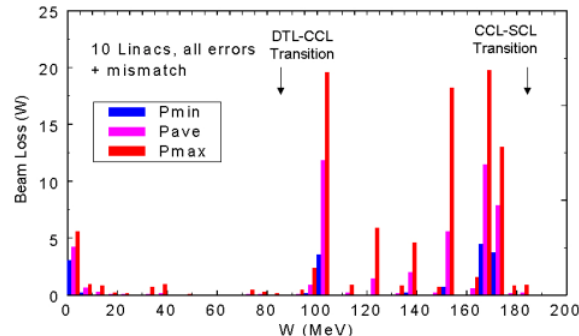
FIG. 8. (Color) Beam loss plots with machine imperfections and mismatch for the original MEBT. Most beam loss takes place in the CCL and at transitions between